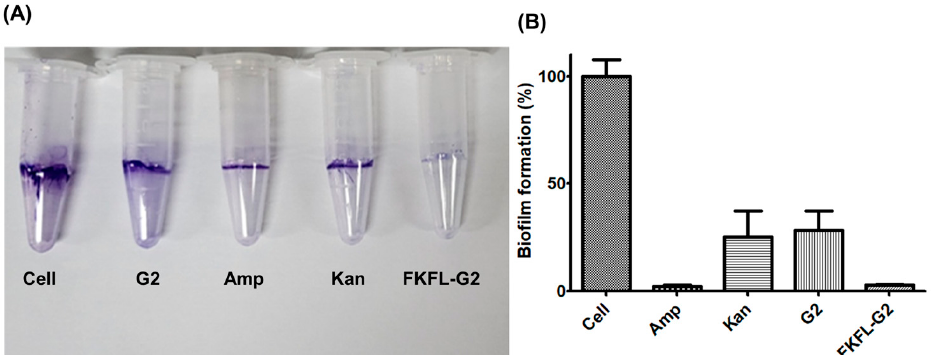
Figure 8. Bio fi lm assay results illustrating the e ff ect of FKFL-G2, second-generation polyamidoam- ine (G2 PAMAM), kanamycin (Kan), and ampicillin (Amp) on E. coli bio fi lm formation. ( A ) Images of treated cells. ( B ) Absorbance data. Results are presented as the mean ± SD ( n = 4).